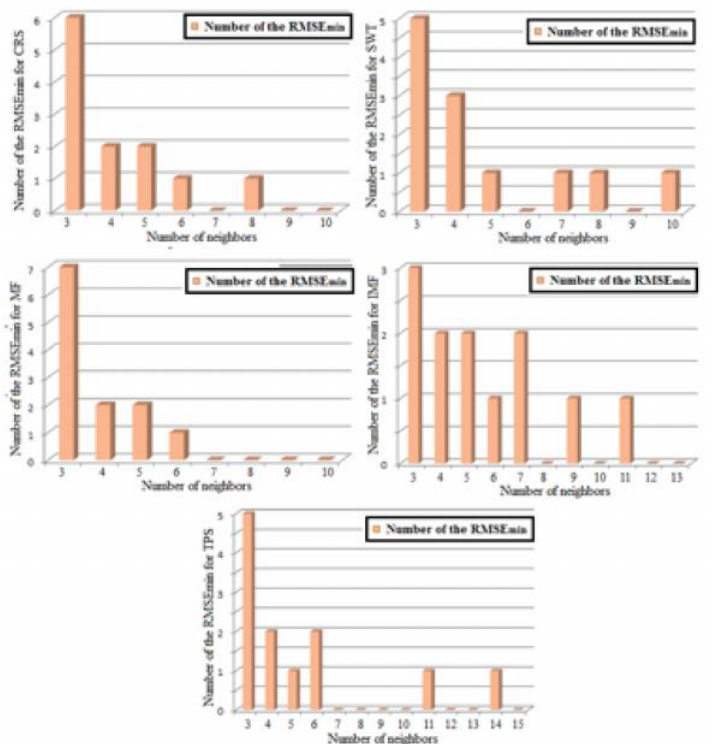
Fig. 2: Results of the RMSE assessment versus number of neighbors and type of functions, including CRS, SWT, MF, IMF min and